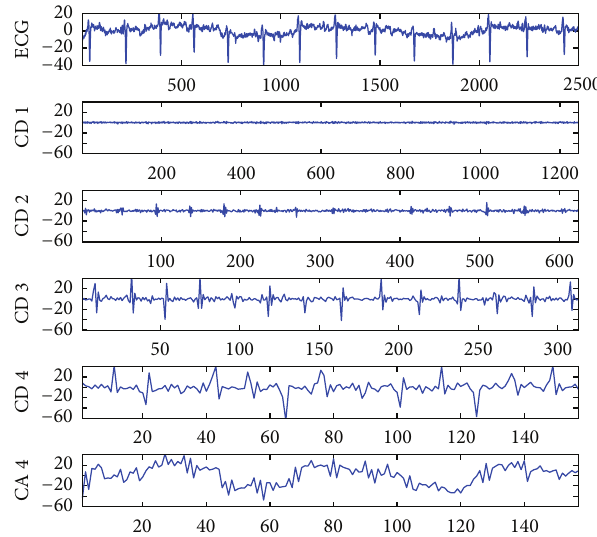
Figure 5: fourth level wavelet decomposition for DaISy dataset lead